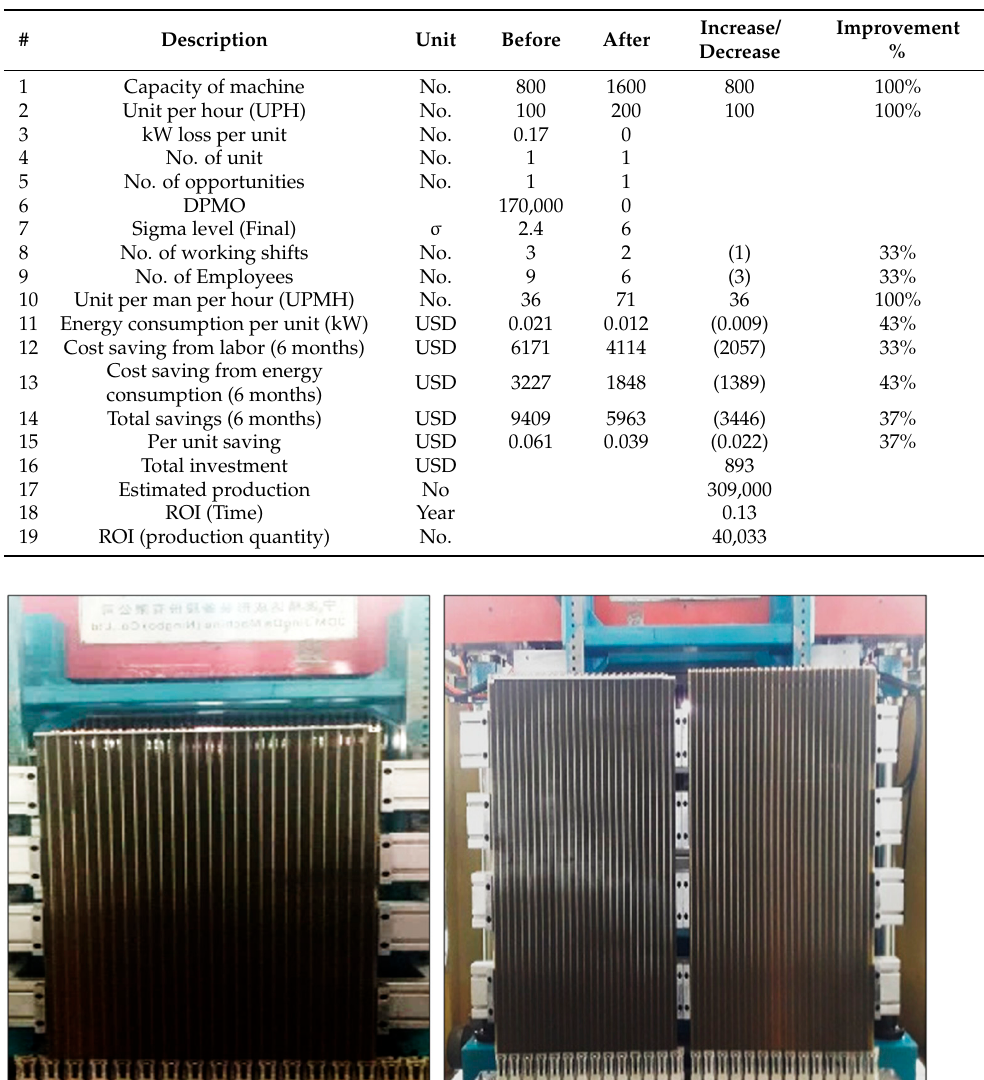
Table 9. Results of expanding machine improvement.